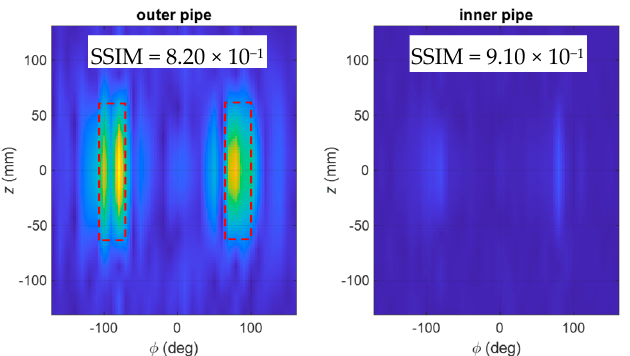
Figure 10. Reconstructed 2D images for two defects on the outer pipe. The red, dashed lines show the locations of the defects.